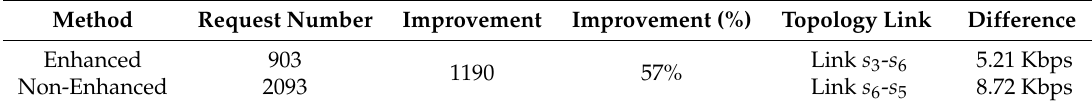
Table 6. Summary of Enhanced vs. Non-Enhanced Methods for Data Rate in Claire video within Study Case